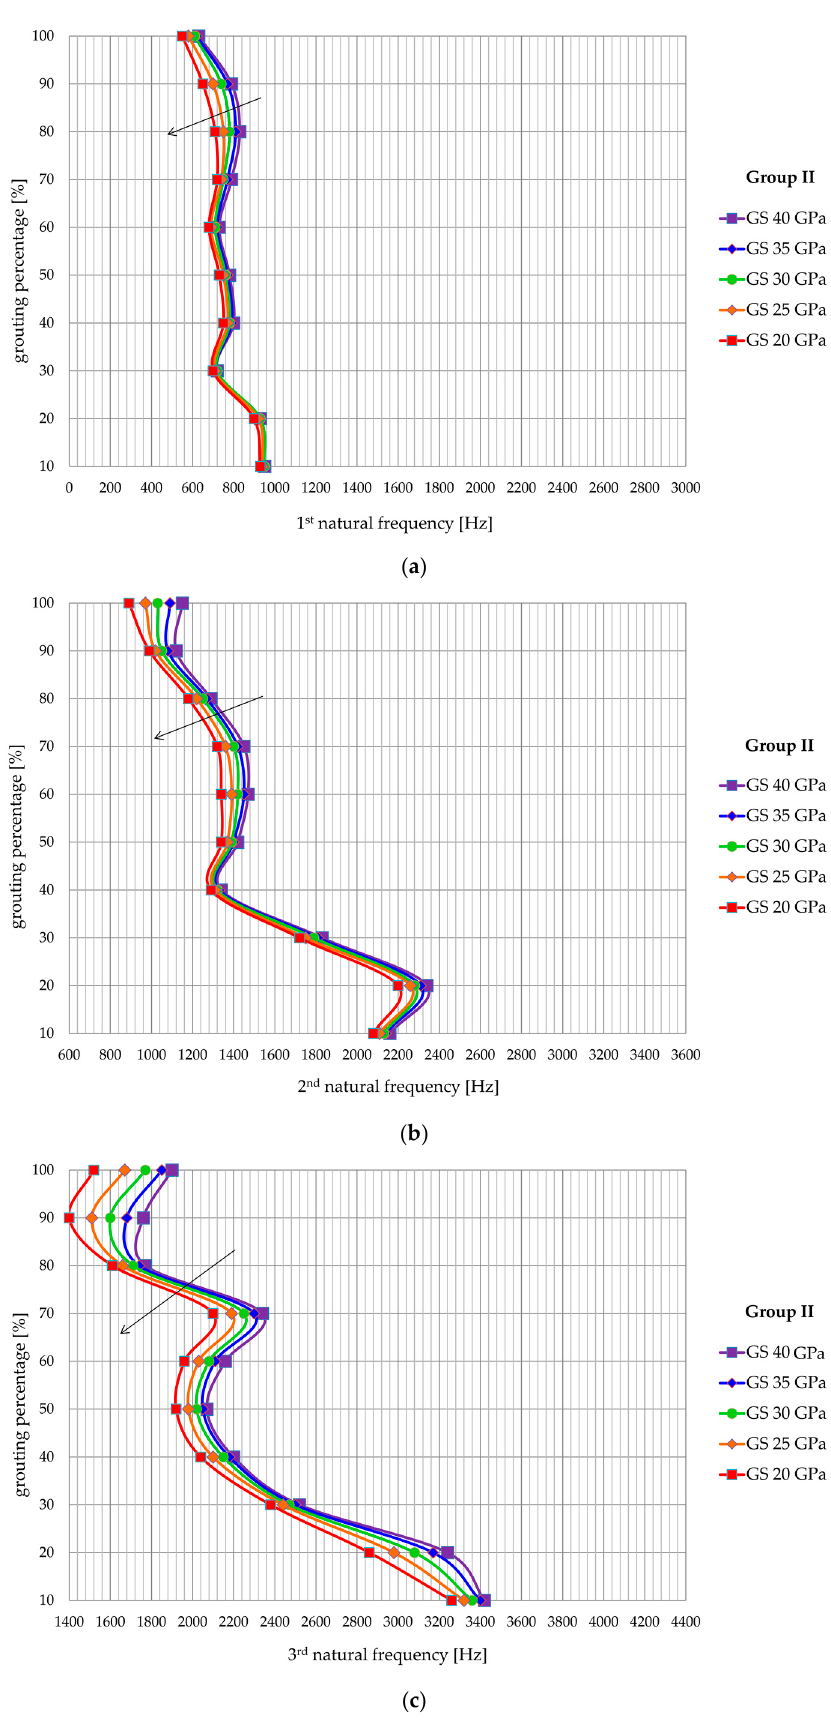
Figure 15. Influence of grout stiffness on ( a ) first, ( b ) second, and ( c ) third natural frequency of Group II models.